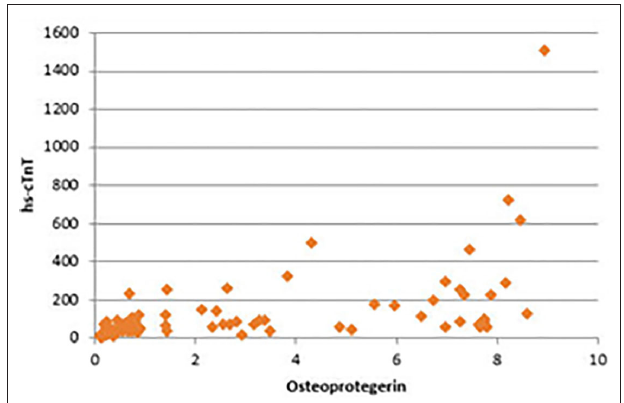
FIGURE 4 | Correlation between serum osteoprotegerin and hs-cTnT.